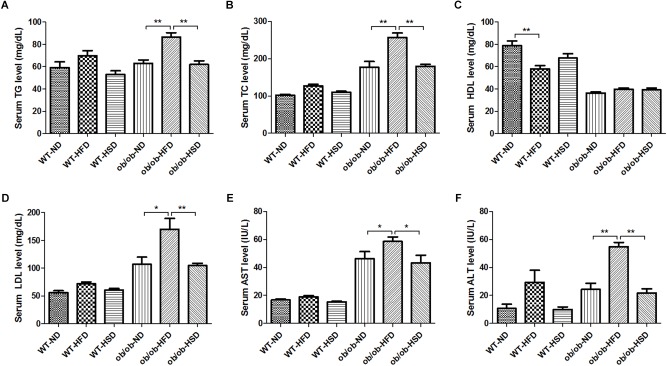
Serum biochemistry parameters. At the end of the experiment, blood was collected from the ventral aorta under Zoletil and Rompun anesthesia. After separation of serum, the serum level of triglyceride (TG) (A), total cholesterol (TC) (B), high density lipoprotein (HDL) (C), low density lipoprotein (LDL) (D), aspartate transaminase (AST) (E), and alanine transaminase (ALT) (F) were determined using commercial enzymatic assay kits. Data were expressed as the means ± SEM and statistically evaluated using one-way ANOVA followed by Bonferroni’s post hoc test. ∗P < 0.05; ∗∗P < 0.01 (n = 7).